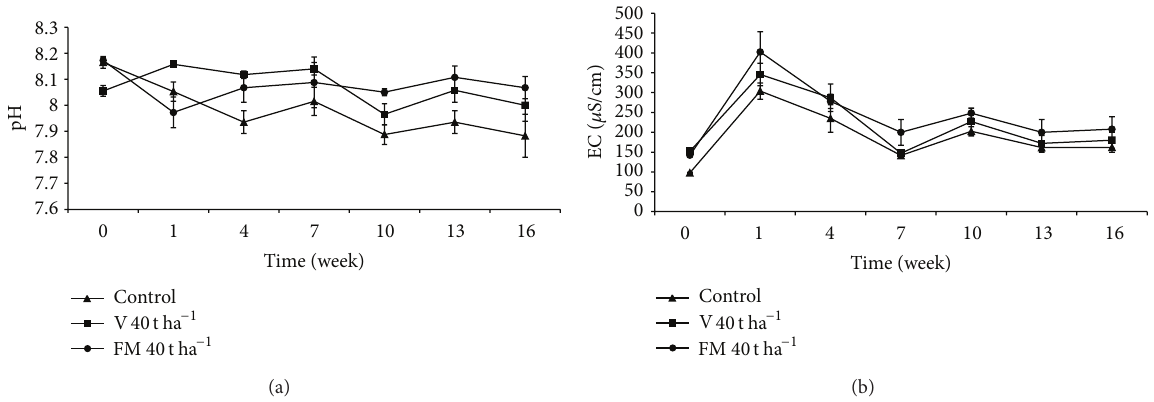
Figure 1: Changes in pH (a) and EC (b) in soils treated with vermicompost (V) and farmyard manure (FM) at the rate of 40t ha −1 . Error bars represent standard errors based on four